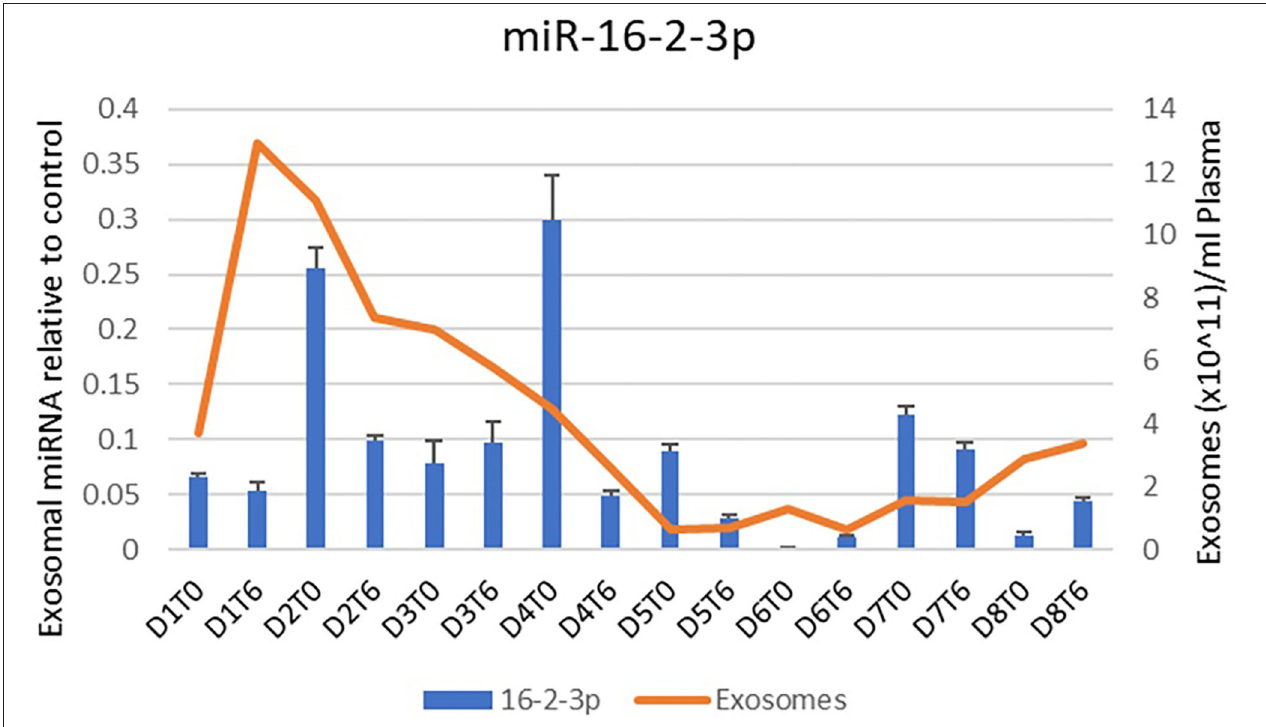
FIGURE 4 | Exosome and Exosomal miR-16-3-3p quantification over time in Case 1.